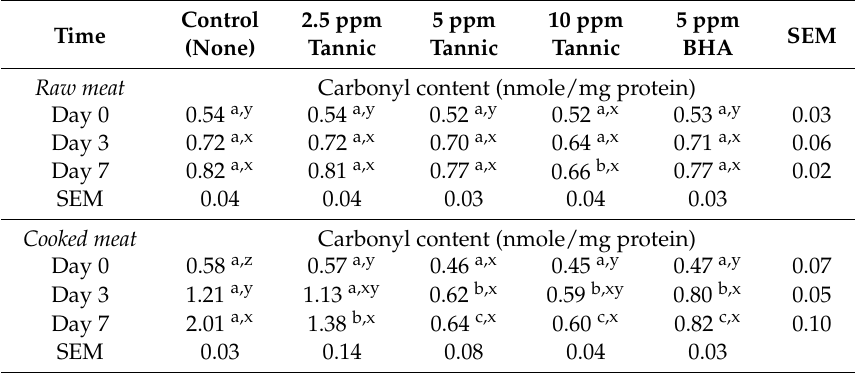
Table 2. Protein oxidation of raw and cooked chicken breast meat with different levels of tannic acid during storage at 4 ˝